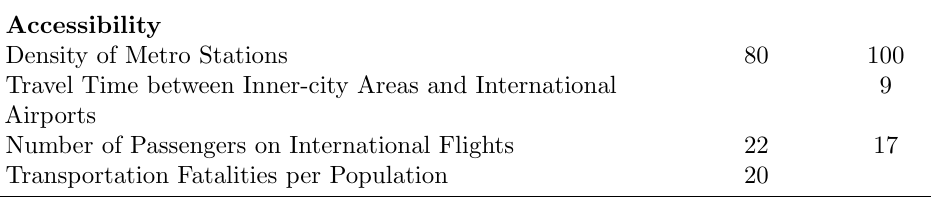
XXQ XXQ Economic